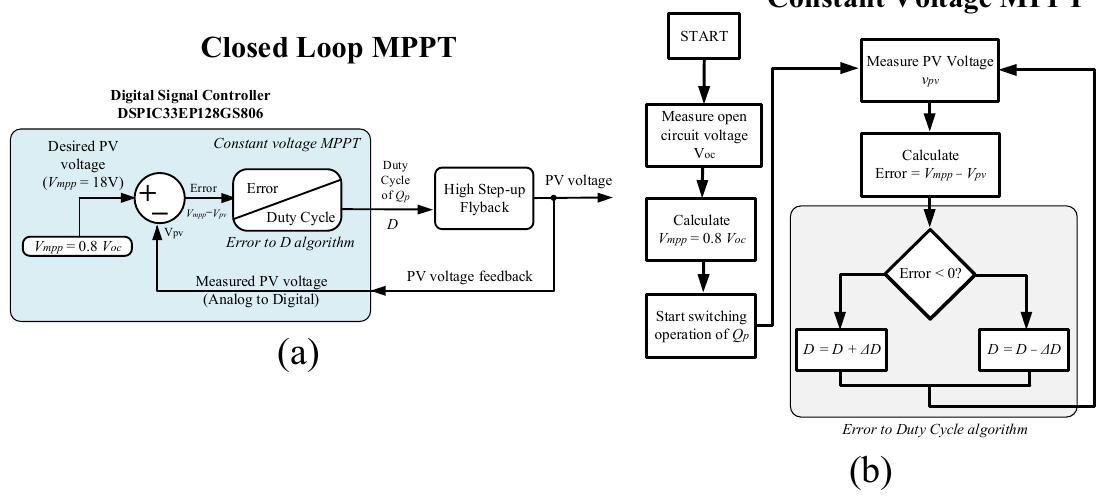
Figure 16. Controller software ( a ) Closed-loop MPPT ( b ) Constant voltage MPPT algorithm.